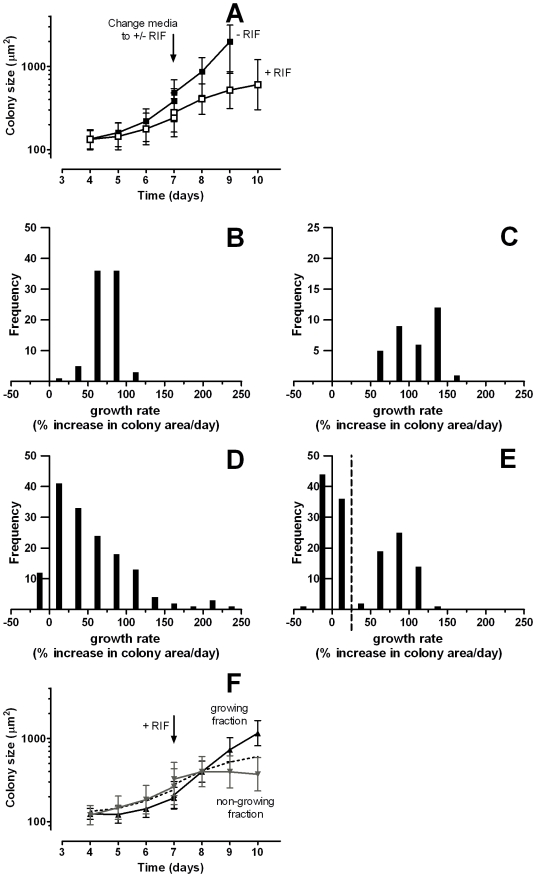
Growth of mixed strains H37Ra and HR1 in the presence of RIF.Microcolonies of mixed cultures of H37Ra and HR1 were grown without RIF for 7 days, then moved to fresh agar with or without RIF from day 7 onwards. A: Average colony sizes of total mixed population incubated with (▪) and without (□) RIF. Average colony size is plotted; bars indicate ±1 standard deviation of measured colony sizes. B, C: Distribution of growth rates (% increase/day) at day 7 (B) and 8 (C) of the total mixed population without RIF exposure. D, E: Distribution of growth rates (% increase/day) at day 7 (D) and 8 (E) of the total mixed population after RIF exposure. In E the vertical dashed line indicates the cut-off value (25%) for growth defined on basis of measured growth rate at day 8. F: Averaged colony sizes of the mixed population with RIF separated into the growing (RIF resistant, black line) and non-growing (RIF susceptible, grey line) populations on basis of the cut-off value shown in E. Average colony size is plotted; bars indicate ±1 standard deviation of measured colony sizes. For reference, data for the complete mixed population is indicated by the dashed line.